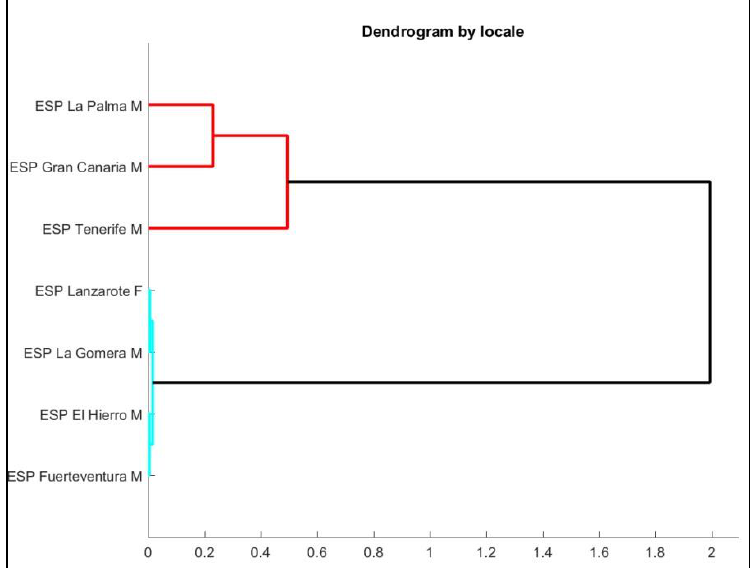
Figure 5. Dendrogram of SVO + Exp declarative sentences by areas (vertical axis) and distance values along the horizontal axis.